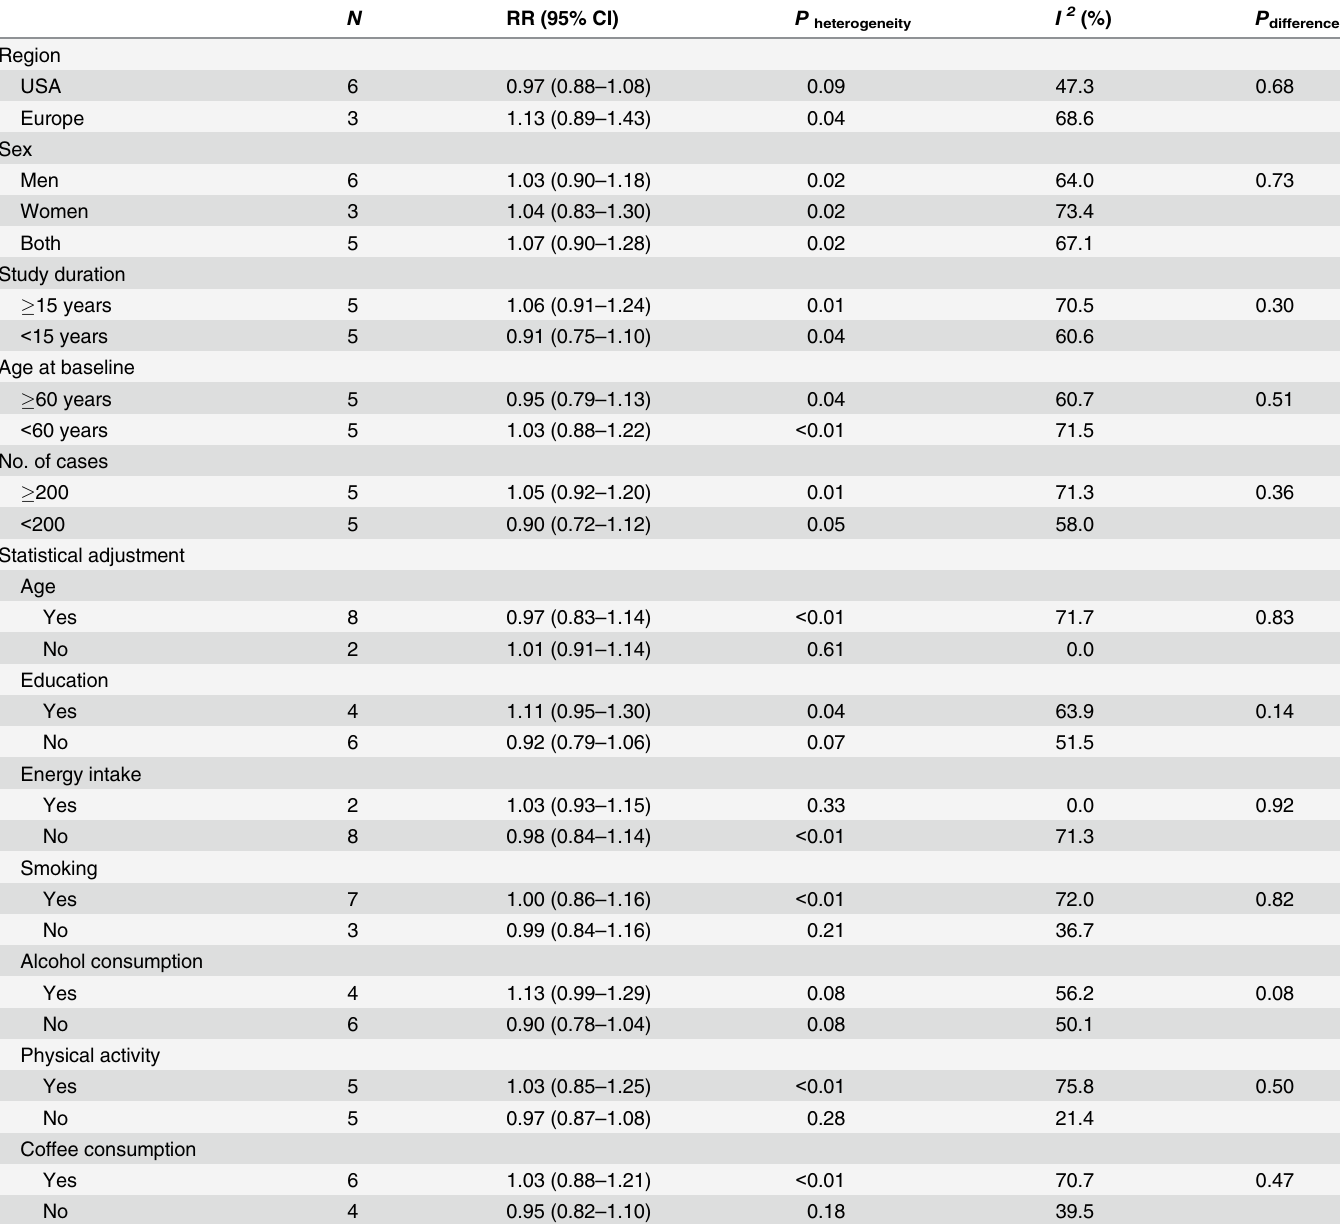
Table 2. Subgroup for the association between body mass index (in increments of 5 kg/m 2 ) and risk for Parkinson ’ s disease. N RR (95%